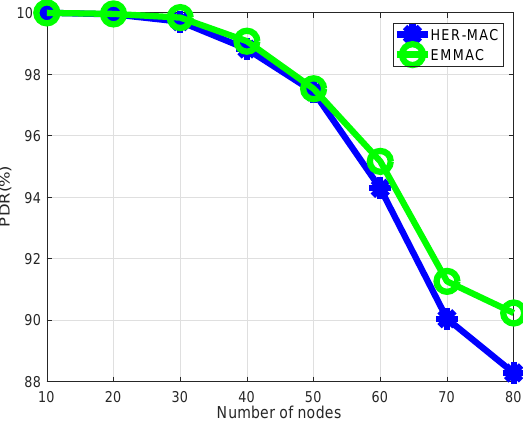
Figure 7. Packet delivery ratio of safety packets.